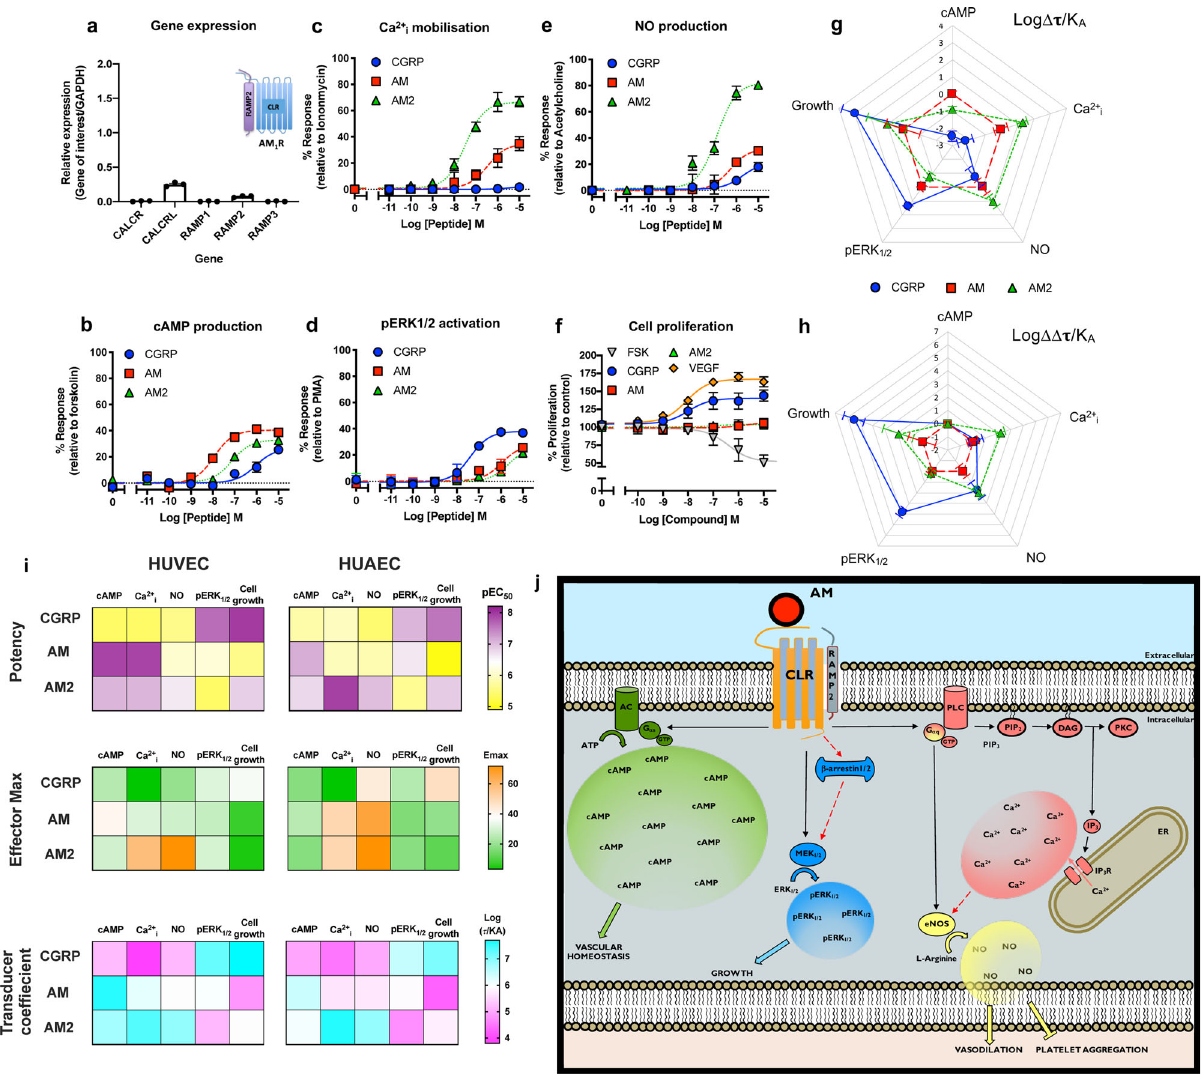
Fig. 1 CGRP family peptide signalling bias in HUVECs. a Expression of CALCR, CALCRL , RAMP1 , RAMP2 , and RAMP3 genes in HUVECs. Data normalised to GAPDH expression. n = 3 independent experiments. b – f Dose – response curves were constructed for HUVECs stimulated with CGRP, AM or AM2 and the cAMP levels quanti fi ed relative to forskolin (100 μ M) ( n = 7) ( b ), mobilisation of Ca 2 + i relative to ionomycin (10 μ M) ( n = 6) ( c ), intracellular ERK 1/2 phosphorylation relative to PMA (10 μ M) ( n = 4) ( d ), total nitric oxide production relative to acetylcholine (10 μ M) ( n = 3) ( e ), and extent of cell proliferation (after 72 h) relative to vector treated control and VEGF ( n = 3 – 6) ( f ). Data are analysed using a three-parameter non-linear regression curve or the operational model of receptor agonism 27 . g – h Signalling bias plots were calculated as Δ Log( τ /K A ) ( g ) or ΔΔ Log( τ /K A ) ( h ) for each agonist and for each signalling pathway. Determination of values requires normalisation to a reference agonist (AM) alone in ( g ), while for ( h ) values were normalised to both a reference agonist (AM) and a reference pathway (cAMP). i Heatmaps representing the signalling properties between HUVEC and HUAEC cells for potency, effector maximum and the transducer coef fi cient. All data represent mean ± SEM for n repeats. j Representation of the signalling outcomes as a result of AM-mediated receptor activation in a HUVEC. Solid arrows indicate known pathways. Dashed arrows represent possible